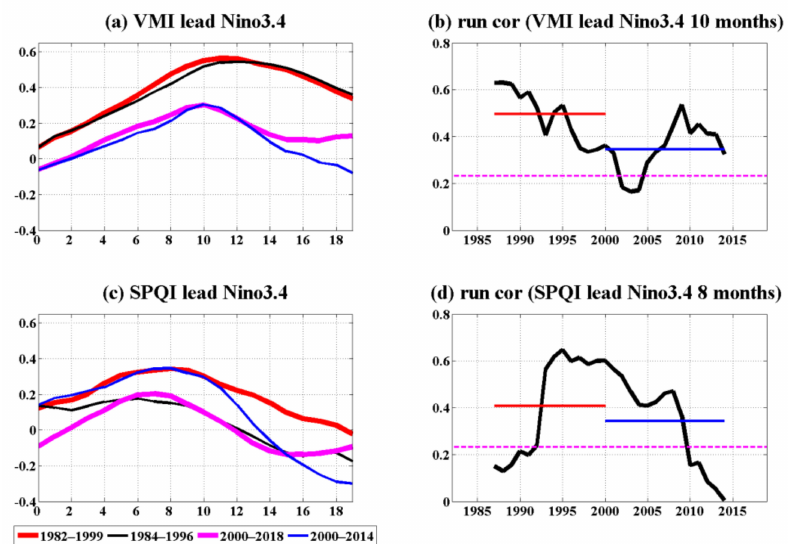
Figure 6. ( a ) Lead correlation between the Victoria mode index (VMI) with the Niño3.4 index for the four periods. ( b ) The 10-year sliding-window correlation between the VMI and the Niño3.4 index with a lead time of 10 months. (The red and blue lines show the mean running correlation coefficient corresponding to the underlying periods, and the pink dashed line shows that the correlation coefficients are significant at the 95% confidence level.) ( c ) As in ( a ), but for the relationship between the South Pacific quadrupole index (SPQI) and the Niño3.4 index. ( d ) As in ( b ), but for the 10-year sliding-window correlation between the SPQI and the Niño3.4 index with a lead time of 8